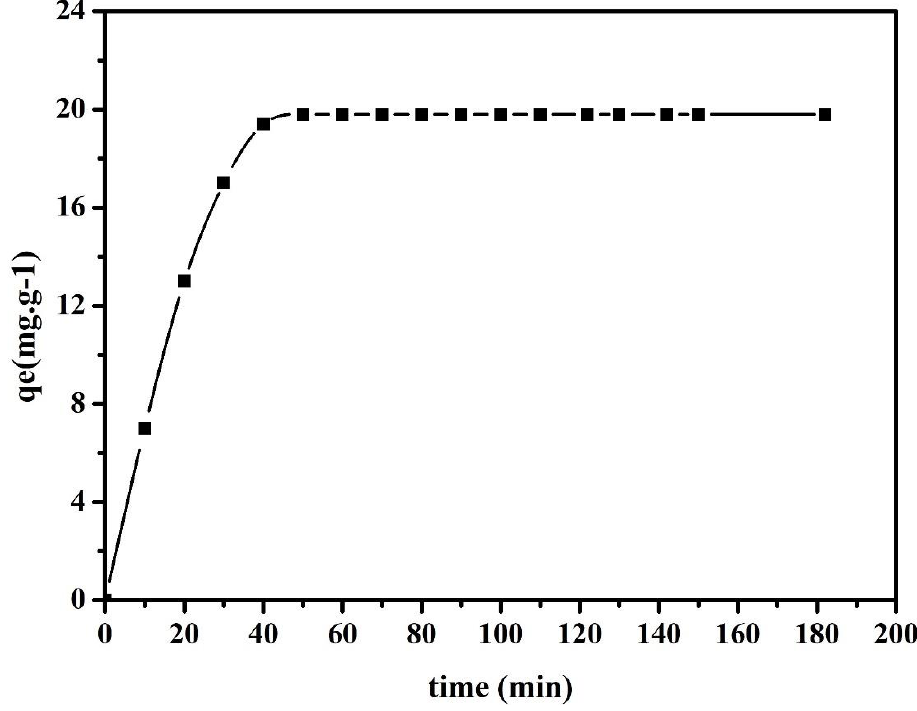
Figure 5. Adsorption weight of methylene blue versus contact time.